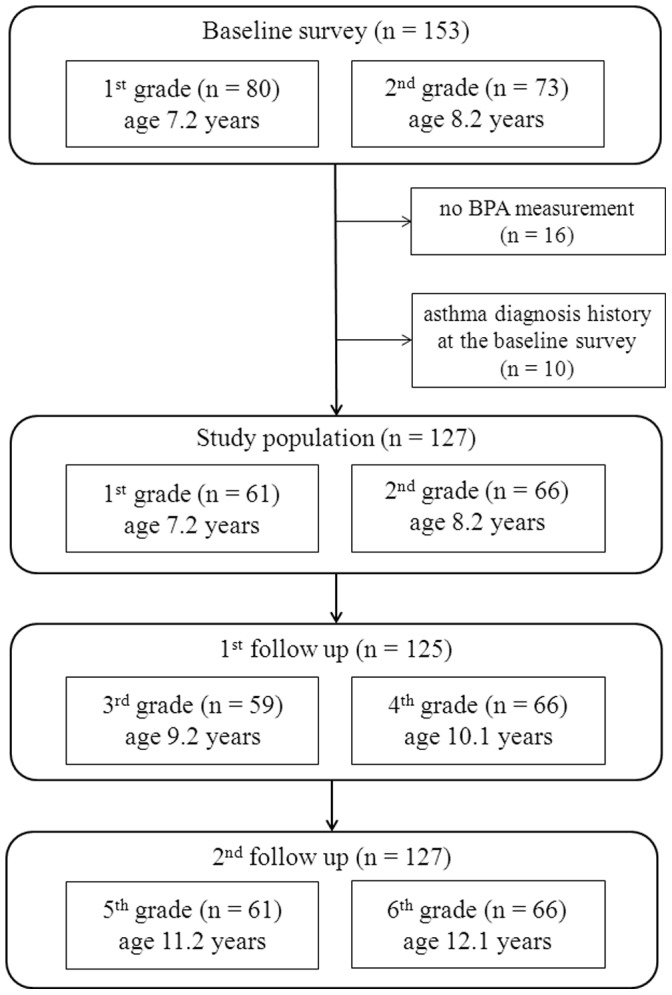
Overview of study population sampling and follow-up.